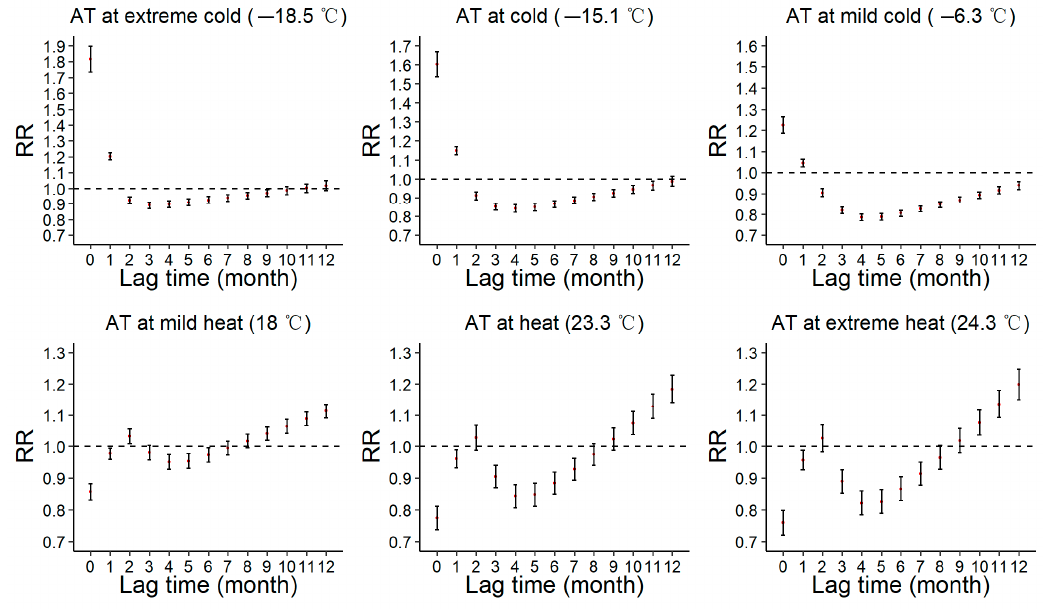
Figure 5. The distribution of RR at various lag months with a reference of medium value 7.8 ◦ C in Xinjiang from 2004 to